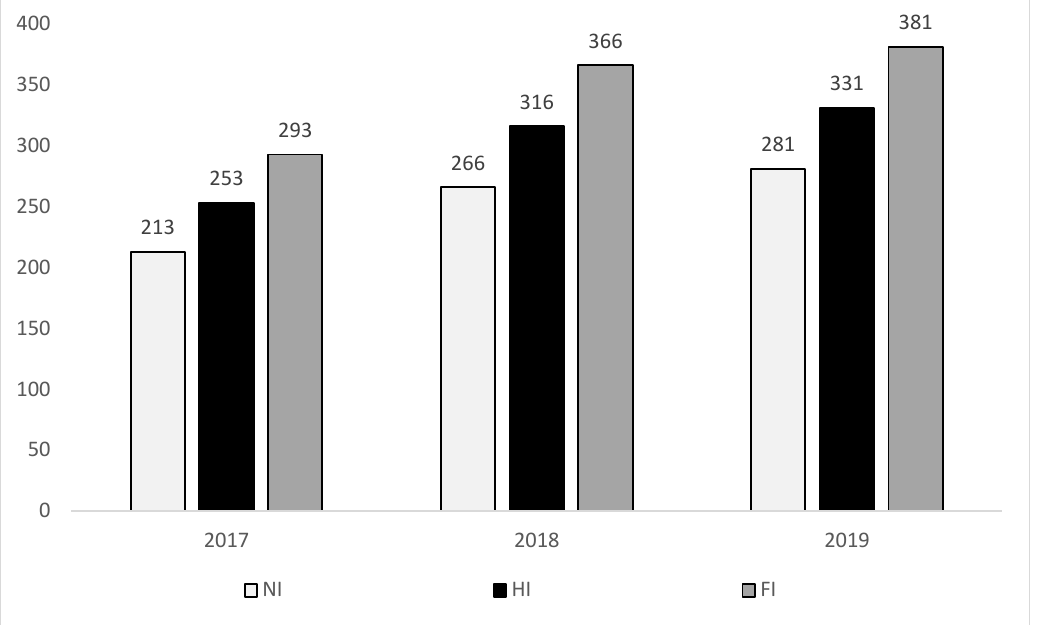
Figure 1. Irrigation amounts during the vegetative period of soybean (cv. Pannonia Kincse) in 2017, 2018, and 2019 in Debrecen, Hungary. NI: non-irrigated, HI: half-irrigated, FI: fully irrigated. Final plot number was 36 (3 irrigation regime × 3 fertilization rates × 4 replications). The plot area was 49.68 m 2 with 12 rows in each